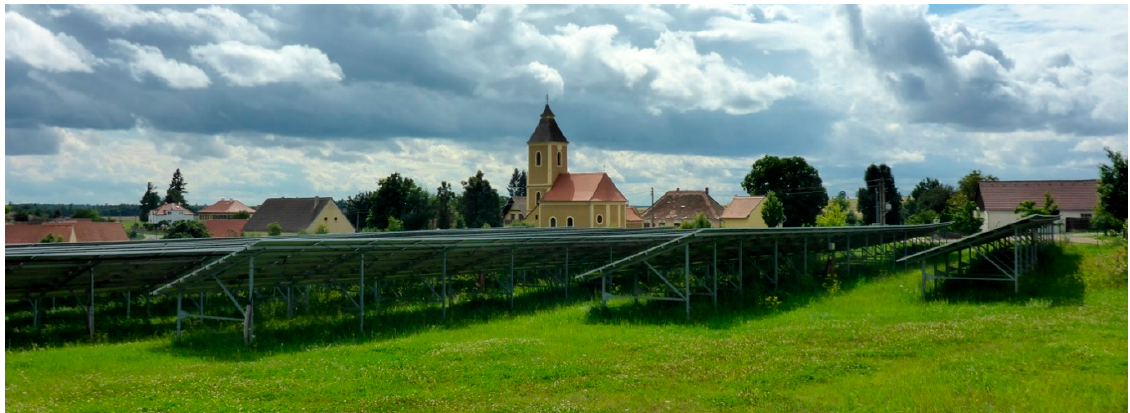
Figure 2. PV plant on the site of a former cowshed. Image by Tomáš Krej č í (Chvalatice, the Czech Republic, 15 May 2021).